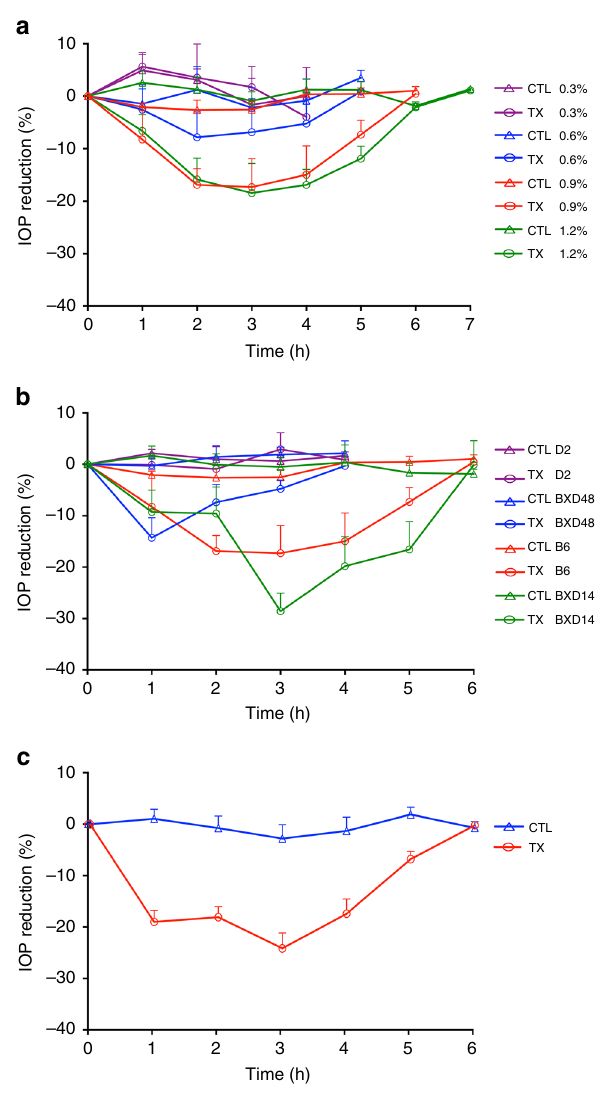
Fig. 5 Cacna2d1 haplotype effects IOP-lowering potency of pregabalin, a speci fi c modulator of CACNA2D1, lowers IOP in B6 mice in a dose- dependent manner. a We measured a dose-dependent reduction in IOP compared to control treatment after a single application of ophthalmic formulation containing a range of concentrations of pregabalin from 0.3 to 1.2%. The minimal concentration required to produce the maximum reduction in IOP is 0.9% (mean ± SEM; n = 6). Statistical details are provided in Table 1. b Pregabalin-induced IOP reduction is haplotype- speci fi c. Mice carrying the B parental allele of Cacna2d1 (i.e., B6 and BXD14) are more responsive to pregabalin (0.9%) than mice carrying the D parental allele (i.e., D2 and BXD48; mean ± SEM; n = 4 – 6). Statistical details are provided in Table 2. c A single dose of pregabalin eye drops (0.9%) lowers IOP by 22.1% in Dutch belted rabbits. n = 5.